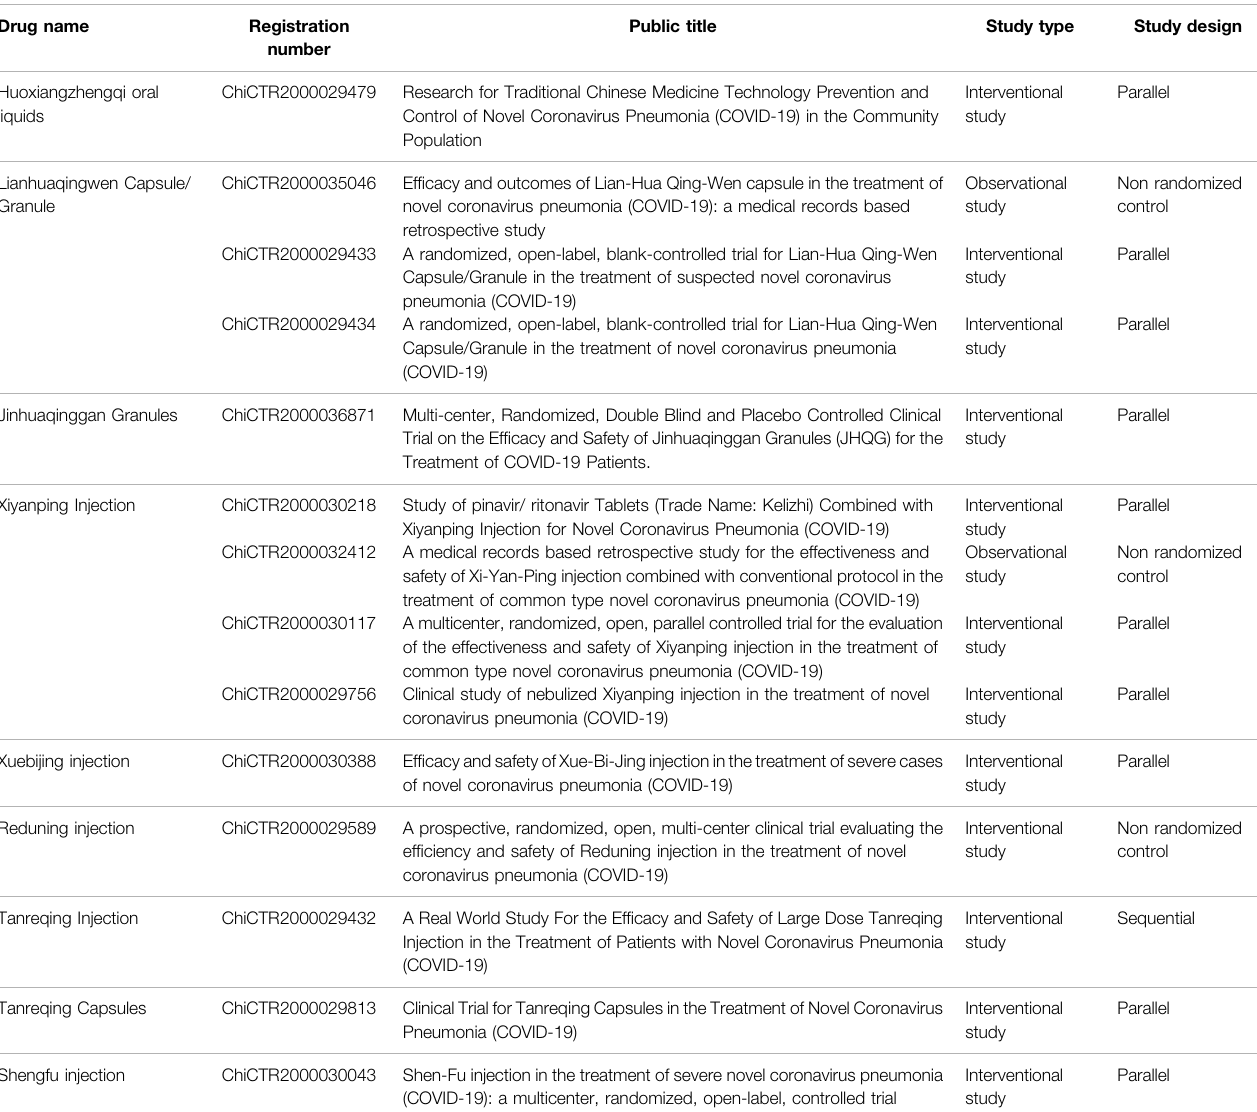
TABLE 3 | Clinical trials on CPMs for